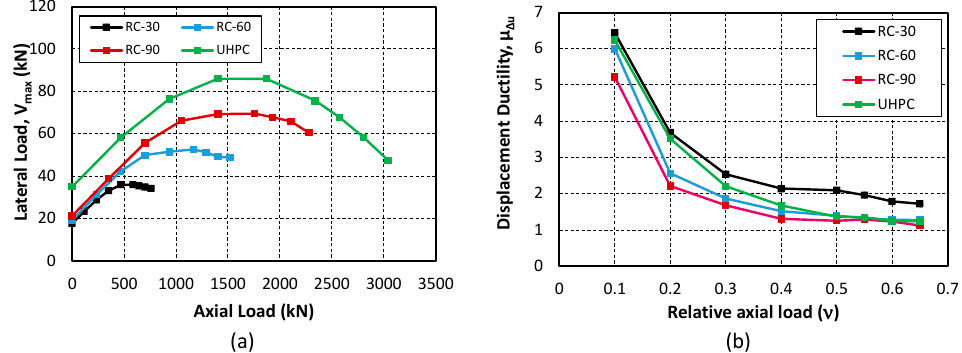
Figure 10. Maximum load and displacement ductility in the specimens made entirely of one concrete type and B500SD reinforcements. Continuous joint (Phase 1): ( a ) lateral load–axial load; ( b ) displacement ductility–relative axial load.